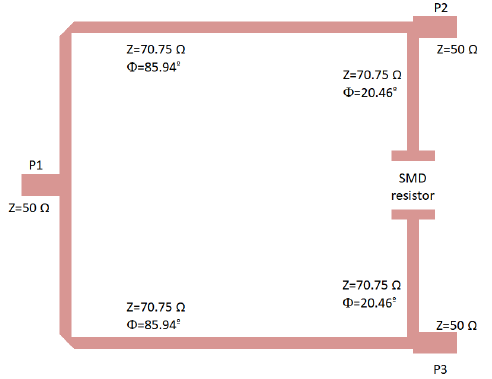
Figure 7. Wilkinson power divider designed on the CLTE-XT substrate, showing the ports and the